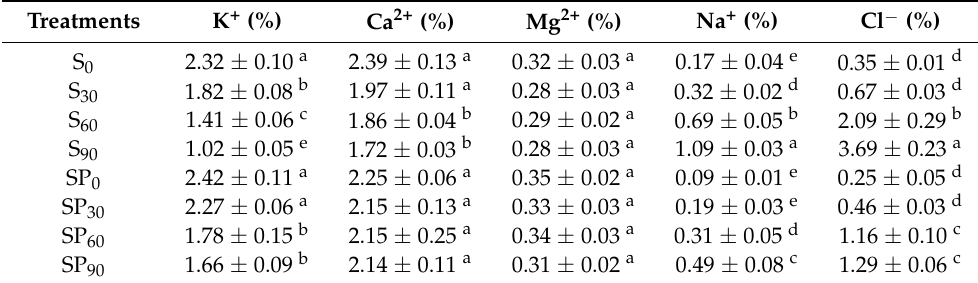
Table 3. Strawberry leaf mineral contents of strawberry plants grown alone or in combination with P. oleracea at differing NaCl